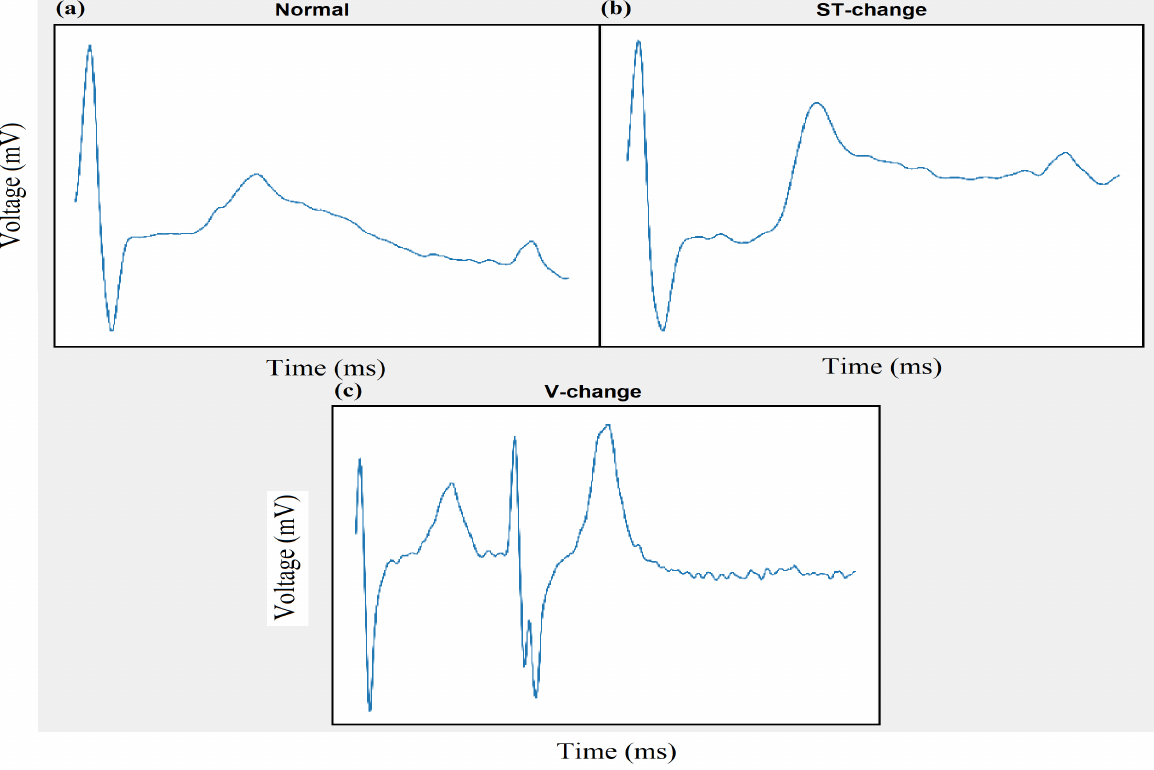
Figure 14. Experiment 3 Inter-patient scheme using DS3.2: Classification of Normal ( a ), ST-Change ( b ), and V-change ( c ) beats using 2-D